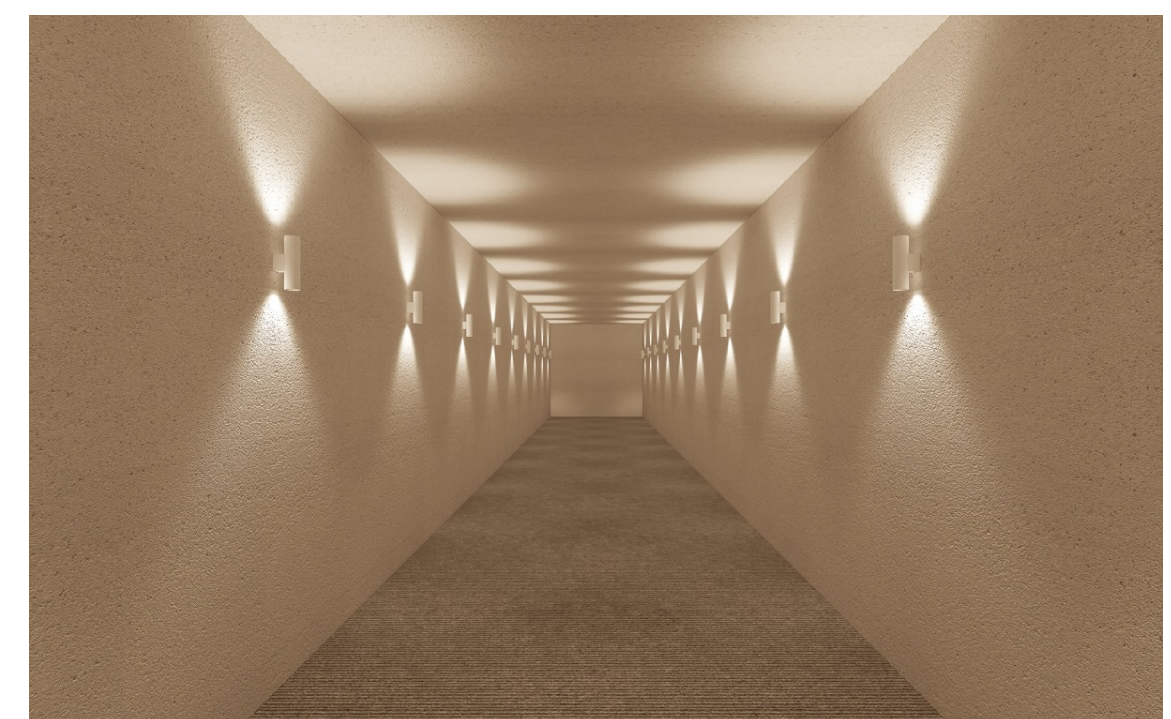
Figure 12. Computer simulation of corridor lighting for variant 9. Lighting variant 10 (Figure 13) was performed using 40 F-type luminaires located on the walls, in two rows along the corridor.